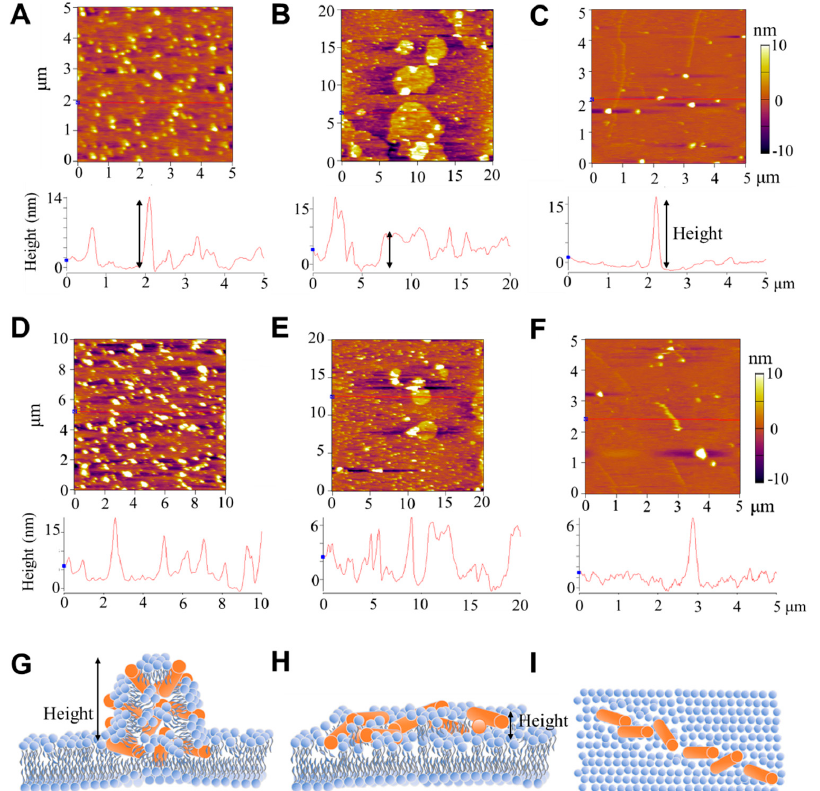
Figure 3. Representative AFM topographies of SLBs after AS4-9 exposure. Images ( A – C ) were obtained at different regions in a SLB membrane. ( D – F ) were captured from another sample. The corresponding height profiles are shown at the bottom. The orange background refers to the SLB surface, and the white regions refer to the aggregates/bulges on the surface. Before characterization, the membrane, consisting of PC lipids, was exposed to AS4-9 at 2.0 μ g mL − 1 for 40 min under a low-ionic-strength and neutral-pH condition. ( G – I ) Drawings showing the corresponding membrane structure in side ( G , H ) or top views ( I ). Orange rod: peptide; blue: lipid. Black arrows represent the height of the corresponding structures.